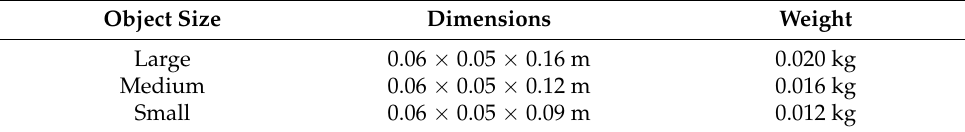
Table 4. Specifications of the power-assisted objects (PAOs).